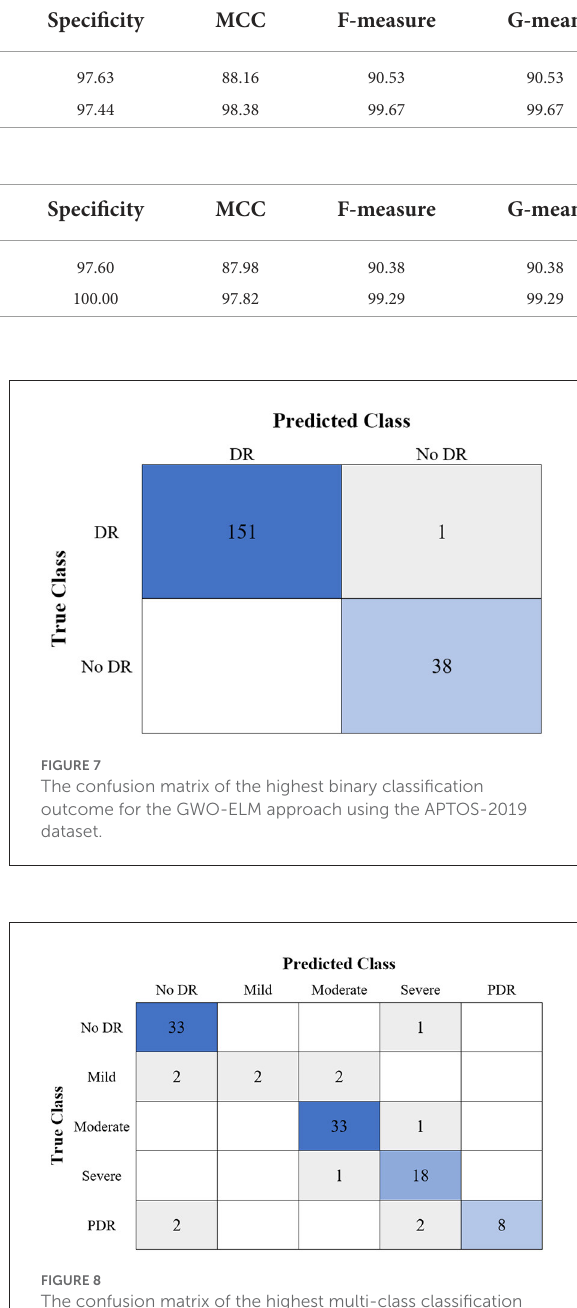
measurements have been used in order to evaluate